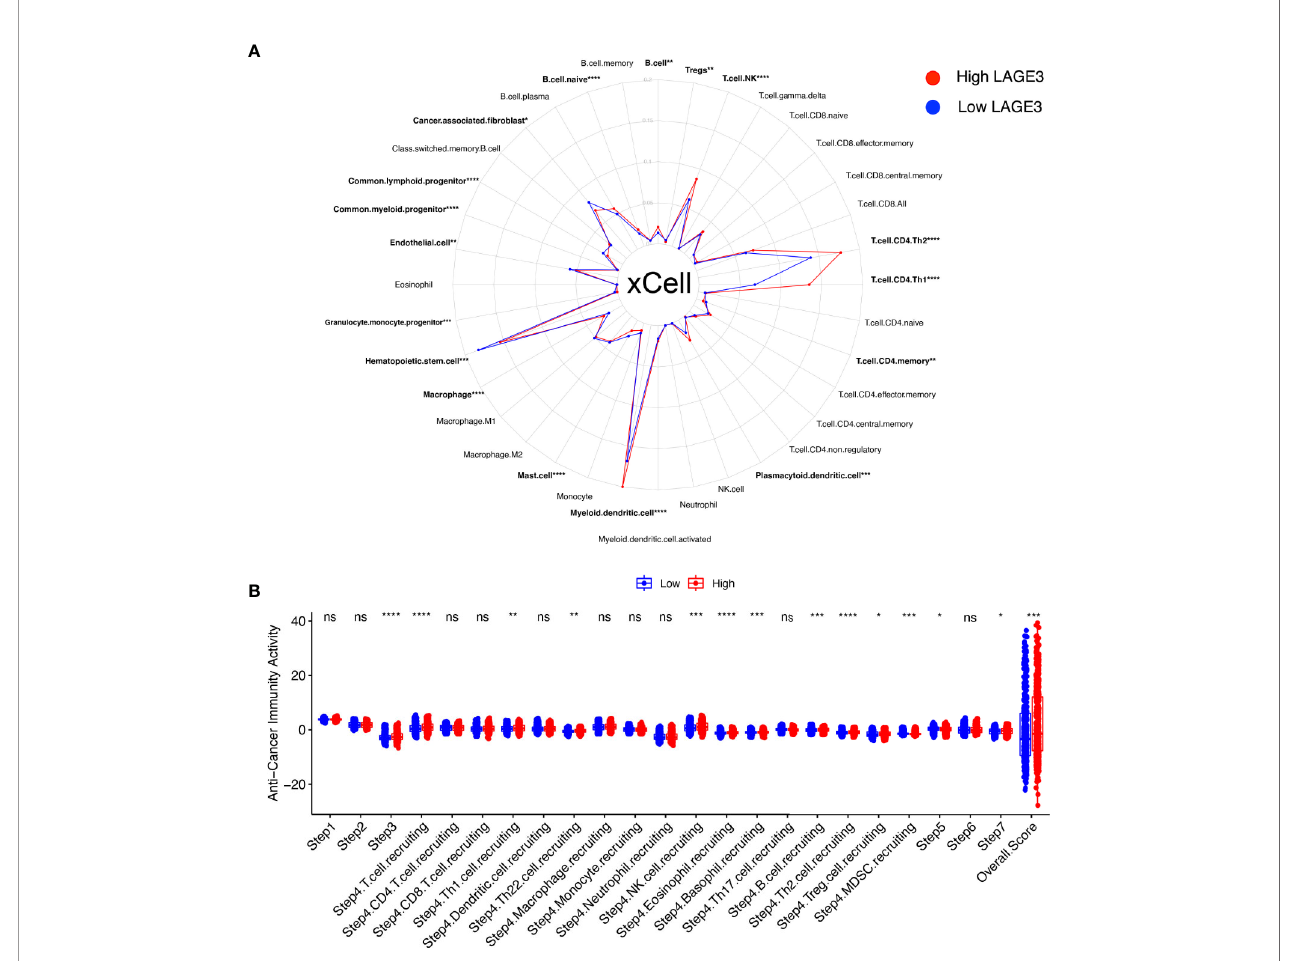
FIGURE 7 | Correlation of LAGE3 with TME components and cancer-immunity cycle in BC. (A) Comparison of different TME components between high and low LAGE3 expression group. (B) Comparison of anti-cancer immunity scores of every cancer-immunity step between high and low LAGE3 expression group. ns, p ≥ 0.05; * p < 0.05; ** p < 0.01; *** p < 0.001; **** p <